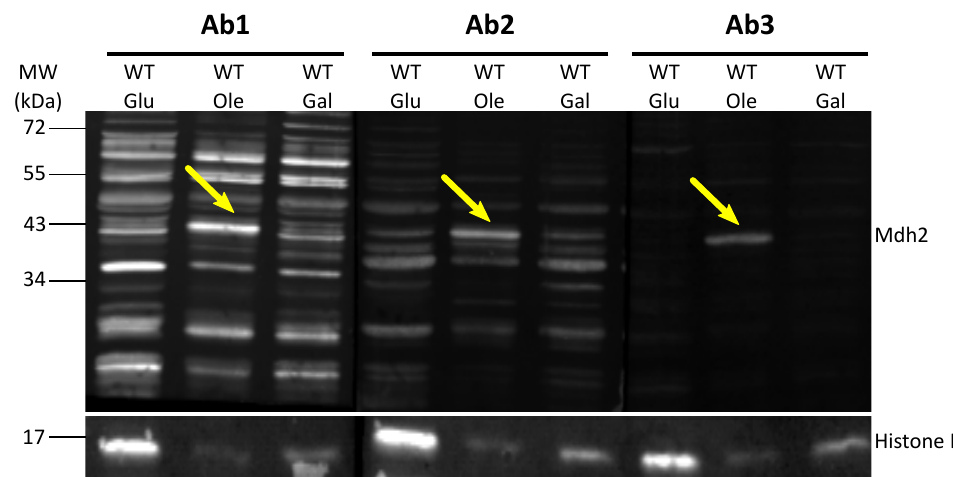
Figure 1. Three new antibodies recognize Mdh2 in cells grown in oleic acid. Western blot analysis was performed on protein extracts of control cells (BY4741) grown in glucose (Glu), oleic acid (Ole) or galactose (Gal) using antibodies 1–3 (Ab1, Ab2, Ab3). Native Mdh2 (41 KDa) is detected by all three anti-Mdh2 antibodies in protein extractions from cells grown in oleic acid as indicated by yellow arrows. Histone H3 was used as a loading control. In total we detected seven times a band at the size of Mdh2 when cells were grown on Oleate: One time using antibody1, three times using antibody 2 and three times using antibody 3.